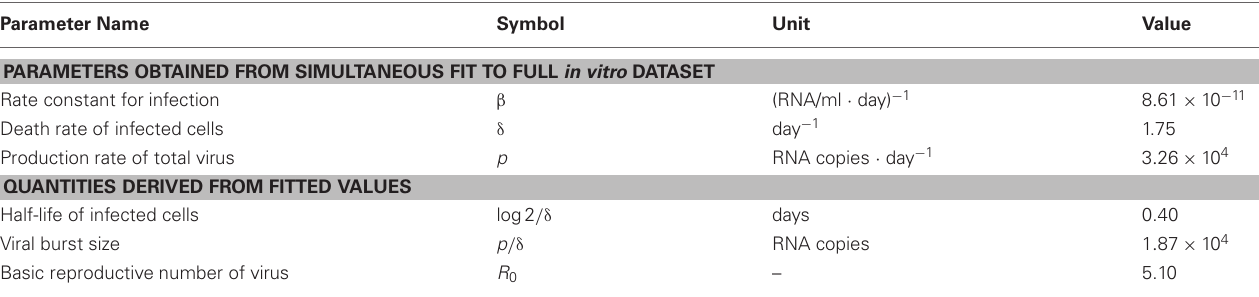
Table 2 | Parameters values and derived